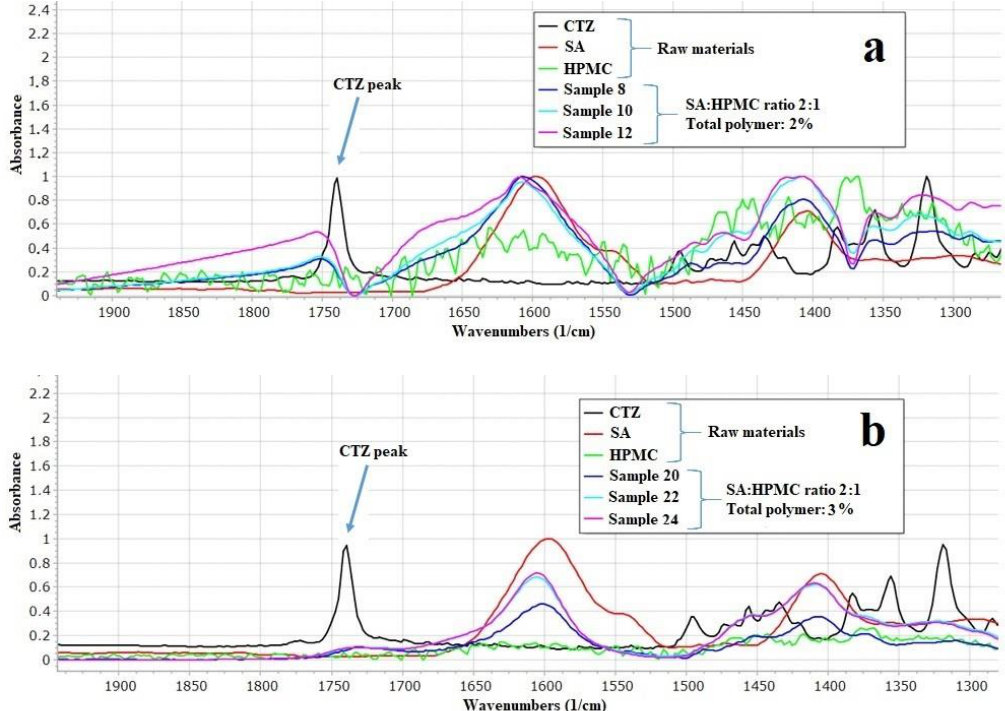
Figure 3. Individual FTIR spectra of SA, HPMC, CTZ, and prepared films ( a ): 2% polymer films and ( b ): 3% polymer films.